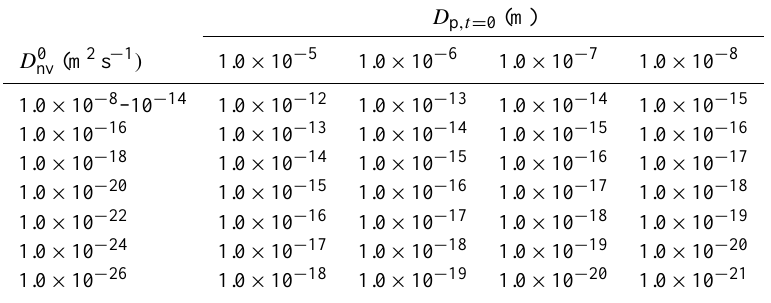
Figure A4. e -folding time contour plots for different instantaneous changes in the saturation ratio of the semi-volatile component ( (cid:49)e s ) and different diffusion coefficient dependencies: (a) (cid:49)e s = 60–80% and logarithmic dependence, (b) (cid:49)e s = 80–60% and logarithmic depen- dence, (c) (cid:49)e s = 60–80% and sigmoidal dependence, and (d) (cid:49)e s = 80–60% and sigmoidal dependence. Models are given in the legend. Table A1. Absolute tolerances used in KM-GAP whilst the self-diffusion coefficient of the semi-volatile component was held constant at 2.0 × 10 − 9 m 2 s − 1 and the saturation ratio of the semi-volatile component was increased and decreased from 1–90 and 90–1%. The absolute tolerance required for stability depended on the self-diffusion coefficient of the non-volatile component ( D 0 nv ) and the initial particle diameter ( D p ,t = 0 ) . D p ,t = 0